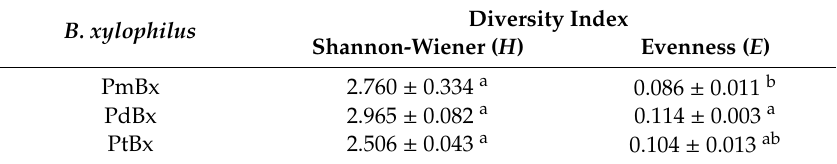
Table 1. Ecological diversity of endo-bacteria communities of Bursaphelenchus xylophilus from different pine host species. 108